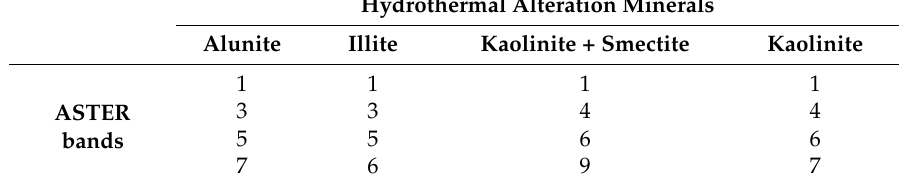
Table 2. ASTER band subsets for mapping alunite, illite, kaolinite + smectite and kaolinite based on